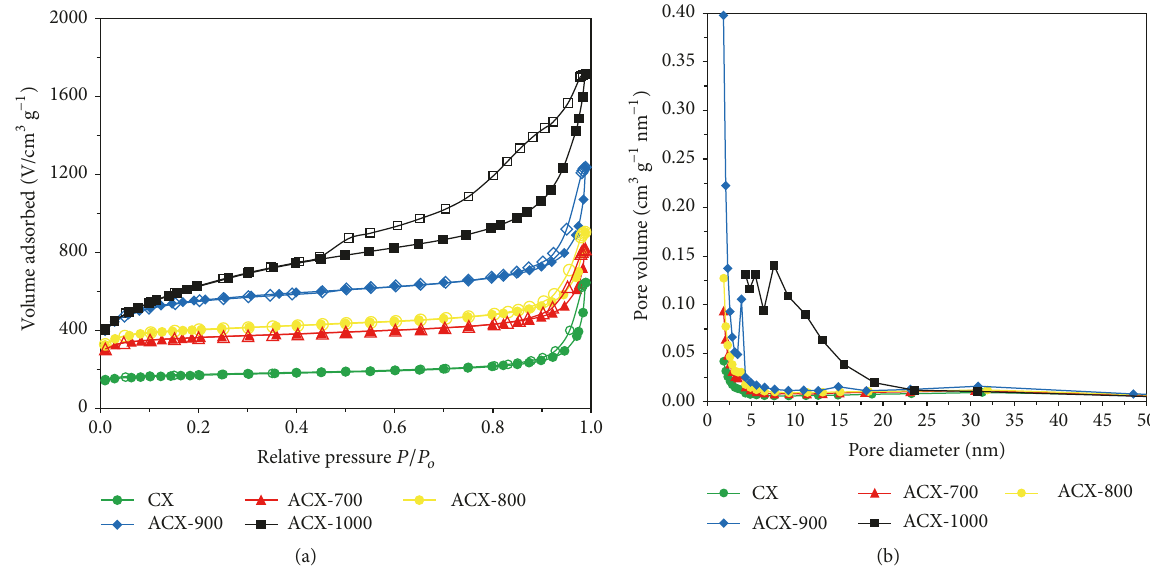
Figure 1: Nitrogen adsorption-desorption isotherms (a) and pore size distributions (b) of carbon xerogel and activated carbon xerogels.